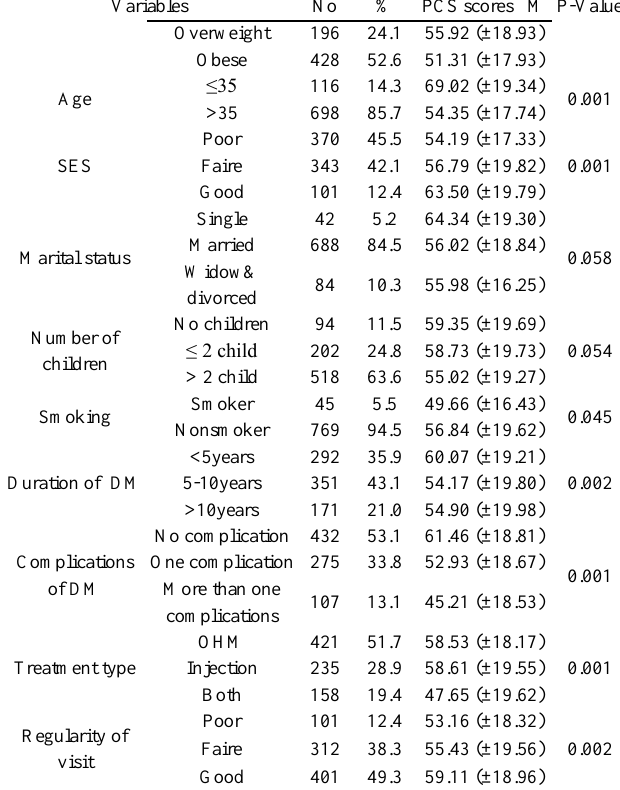
Tab.2. shows that, the obese patients had the lowest difference mean (±SD) of MCS scores significantly in comparison with the other two groups in the total study sample. The comparison of MCS HRQoL scores according to study variables (age, SESI, marital status, number of children, smoking, duration of disease, complications, treatment type & regularity of visit) revealed a statistically significant difference with strata of complications of DM & regularity of visit. Patients with no complications of DM, or with a good regularity of visit had a higher score than their counterparts. The Mental Component Summary score of Health related quality of life Mean (±SD) scores according to